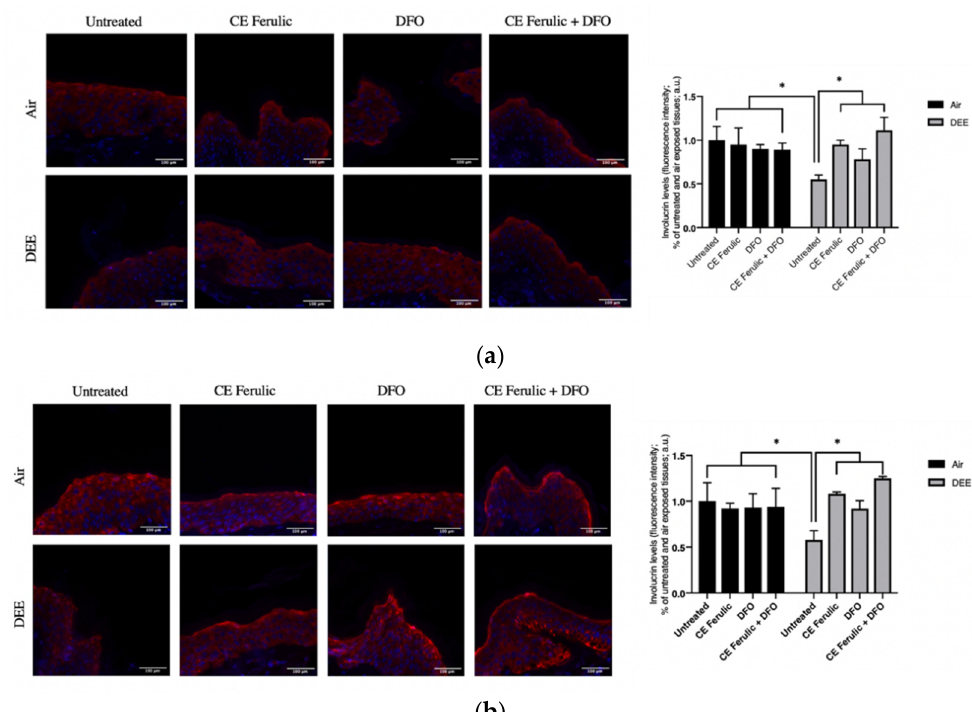
Figure 6. Skin exposure to DEE induces a decrease in involucrin levels, while topical application of CE Ferulic and DFO prevents this effect. Levels of involucrin in human-skin explants untreated or pretreated with the cosmeceutical formulation mixture and DFO, alone or in combination, and exposed to air or DEE at Day 1 ( a ) and Day 4 ( b ). Red fluorescence staining represents involucrin immunoreactivity, while cell nuclei are stained in blue with DAPI. Original magnification 40x. On the right, semi-quantification of the immunofluorescence intensities performed by ImageJ are shown in the histograms. Data are expressed as arbitrary units (averages of three independent experiments), * p < 0.05, by ANOVA. Scale bar = 100 μ m.